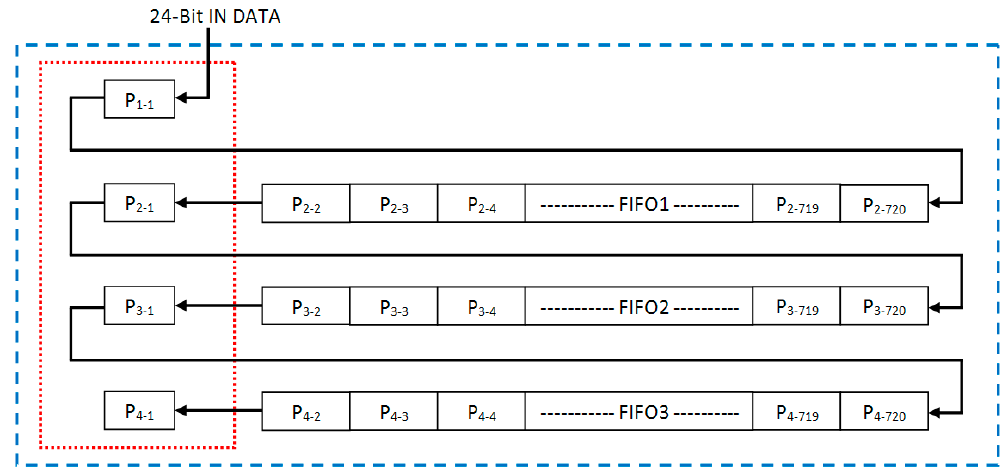
Figure 8. Proposed smart buffer based input buffer memory architecture.